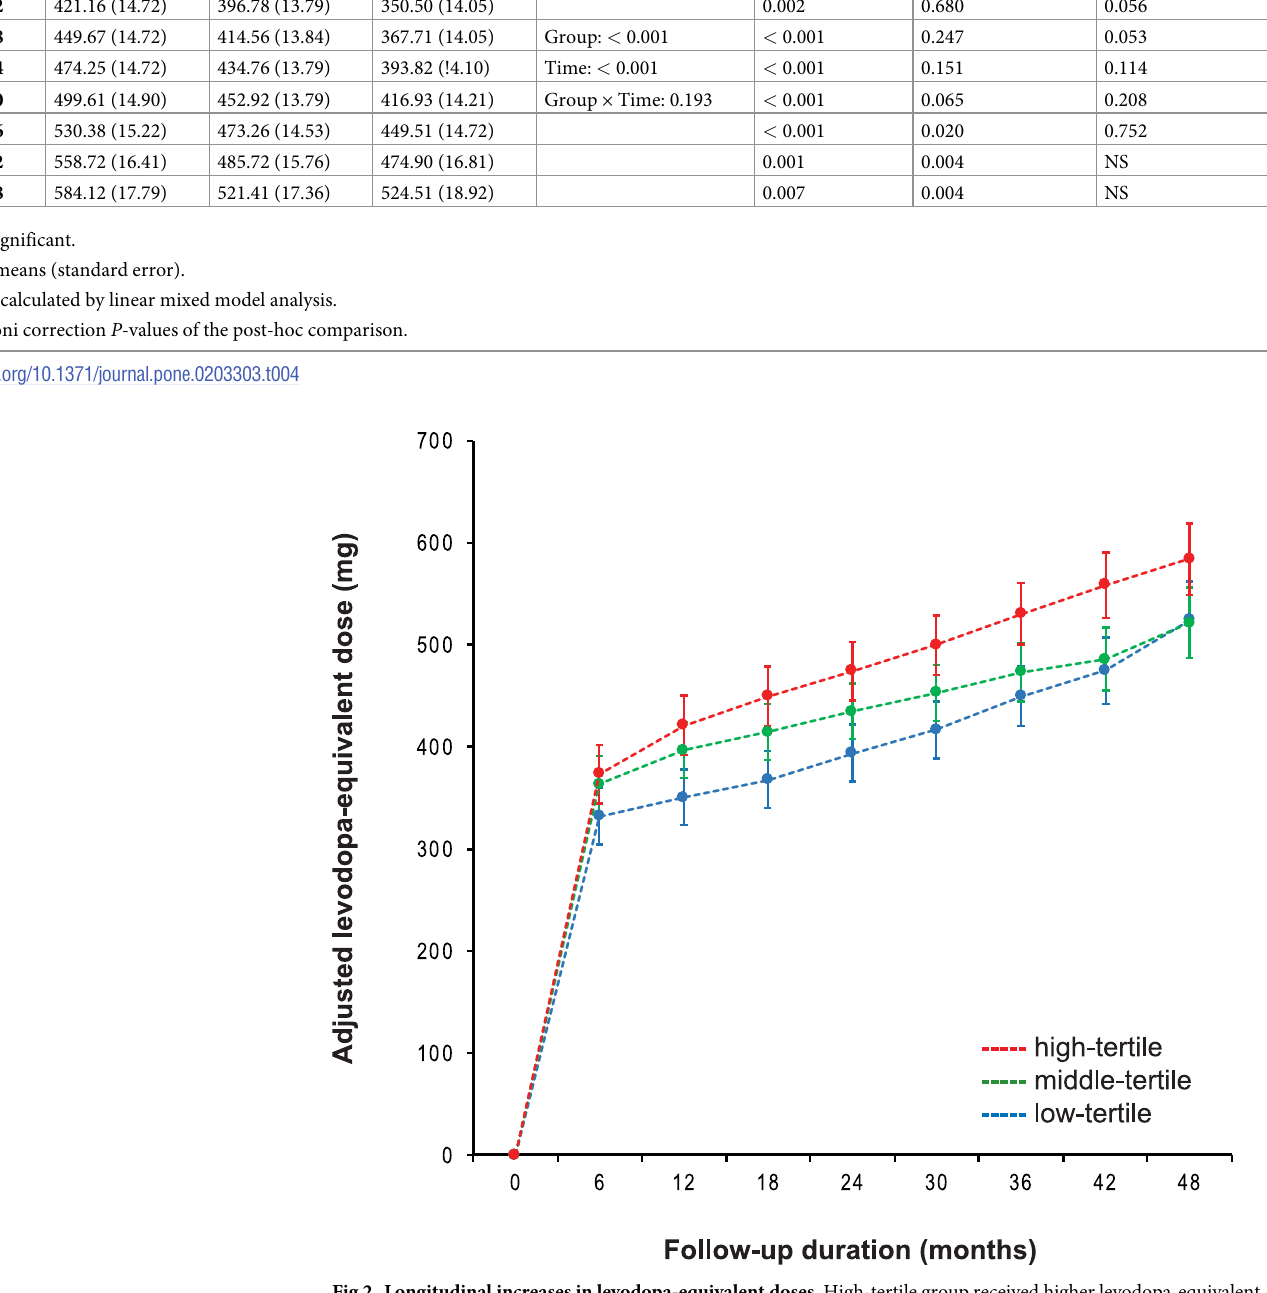
Table 4. Levodopa-equivalent doses during follow-up. Time Depression level, tertile Overall P value a Post-hoc P value b Middle High vs. Low High vs. Middle Middle vs. Low